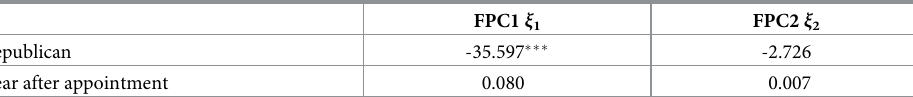
Table 1. Results from linear regression